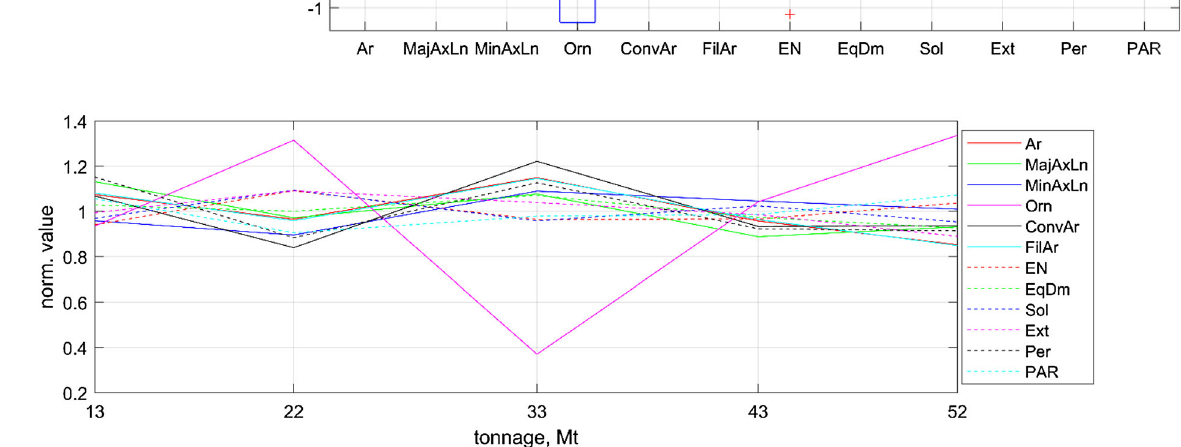
Fig. 8 The trend of the feature mean values